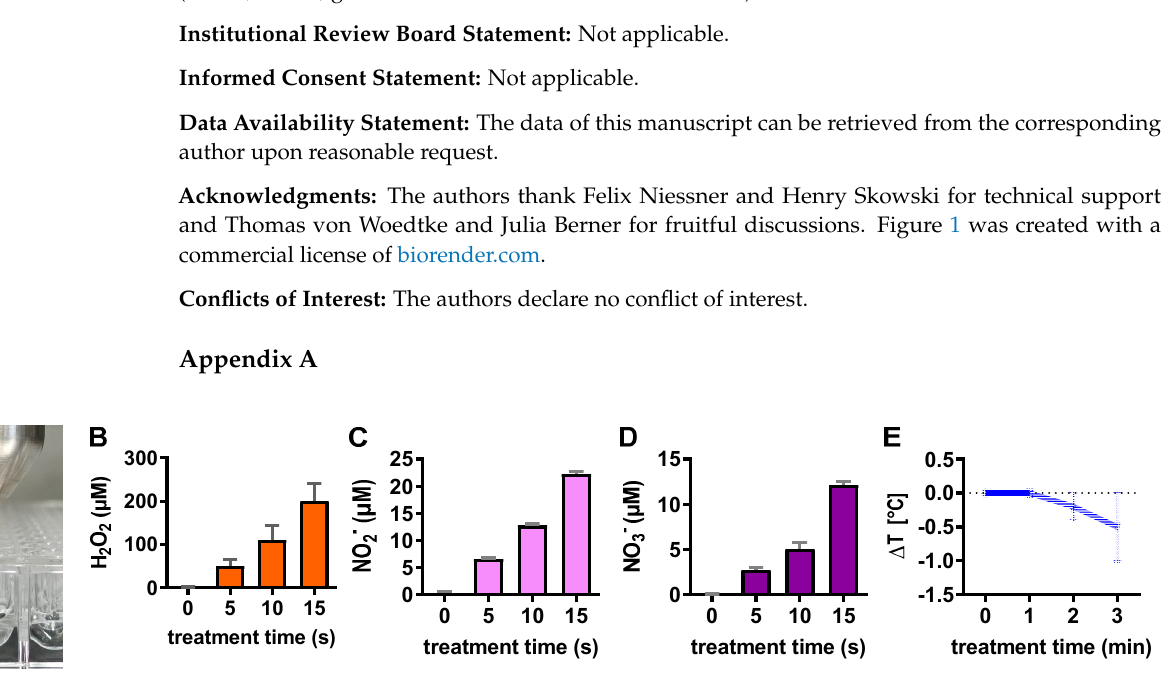
Figure A1. Plasma-liquid analysis. ( A ) treatment setup using the atmospheric plasma argon plasma jet kINPen exposing PBS; ( B – D ) quantification of H 2 O 2 ( B ), nitrite ( C ), and nitrate ( D ) in plasma- treated PBS; ( E ) temperature changes ( Δ ) of plasma-treated liquid normalized to untreated liquid.